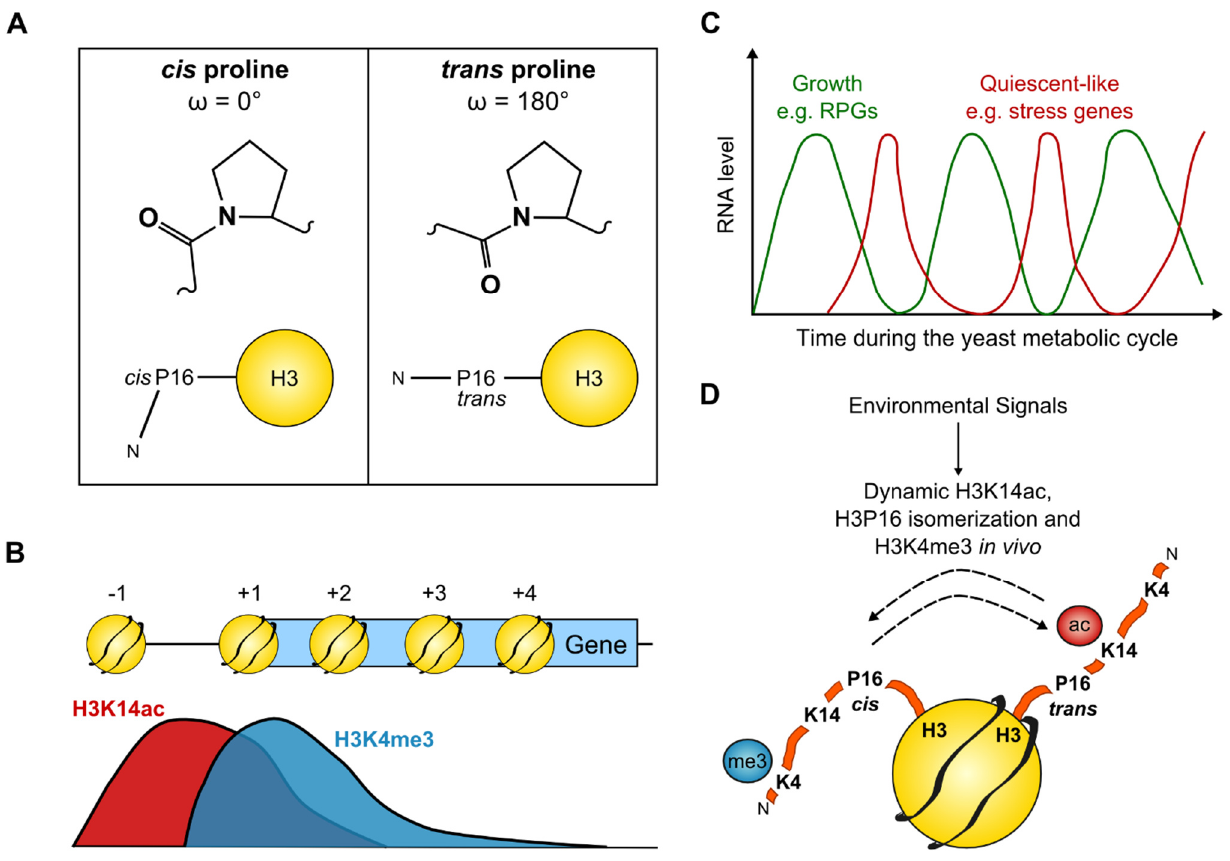
FIGURE 1: (A) Structures of cis and trans proline and a schematic of the histone H3 N-terminal tail with proline 16 in the two possible con- formations. (B) Distribution of H3K14ac and H3K4me3 across a typical gene in yeast. (C) The changes in RNA level of oxidative (green) and reductive (red) genes during the yeast metabolic cycle. (D) Environmental signals lead to dynamic H3K14ac, H3P16 isomerization and altered H3K4me3 in vivo